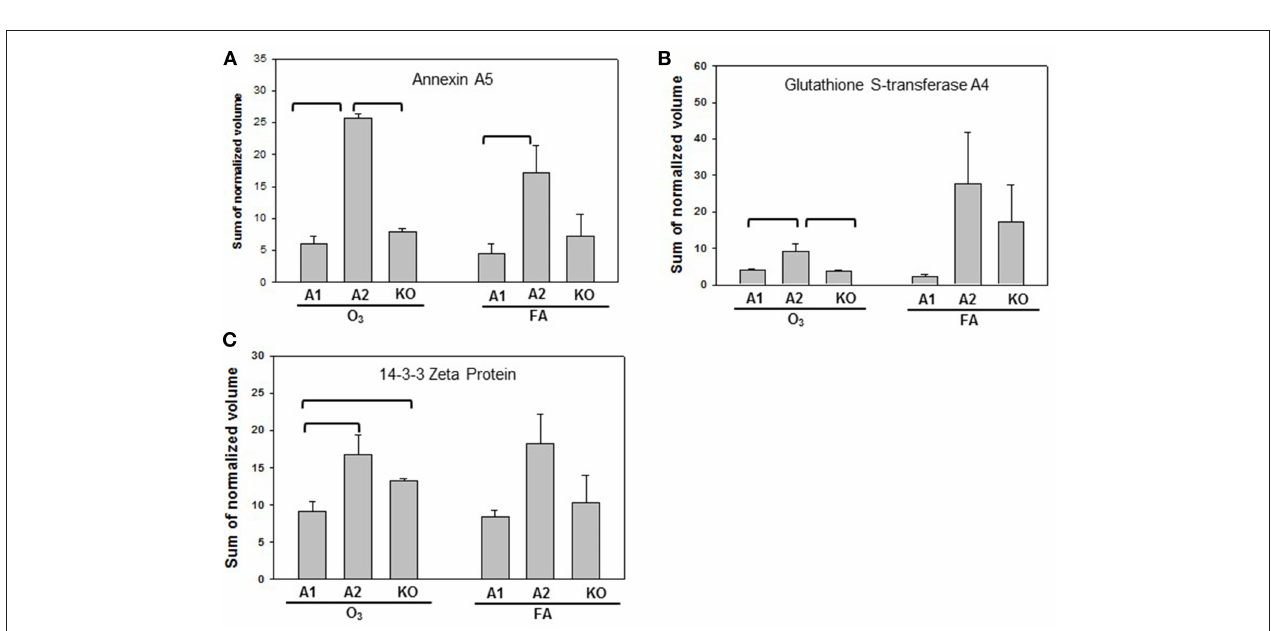
FIGURE 4 | Representative graphs of significant protein changes among genotypes in male mice. The proteins shown exhibit significant differences in at least 2 group comparisons among genotypes of male mice [SP-A1 (A1), SP-A2(A2), KO] after exposure to O 3 or filtered air (FA) following bacterial infection. Histograms depicting levels of each specific protein includes: (A) annexin A5; (B) glutathione S-transferase A4; (C) 14-3-3 zeta protein. Comparisons between groups that were statistically significant ( p < 0.05) are indicated with a